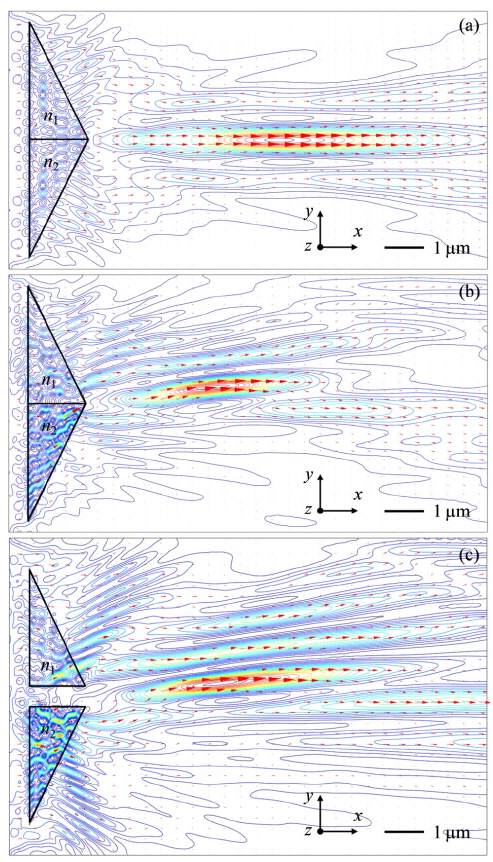
Figure 8. Poynting vectors and energy flow streamlines for triangular Janus micro-prisms at ( a ) n 1 = n 2 = 1.5, ( b ) n 1 = 1.5, n 2 = 1.88, and ( c ) n 1 = 1.5, n 2 = 1.88, d = 500 nm. The height and width of triangular Janus micro-prisms are h = 1.5 μ m and w = 3 μ m.